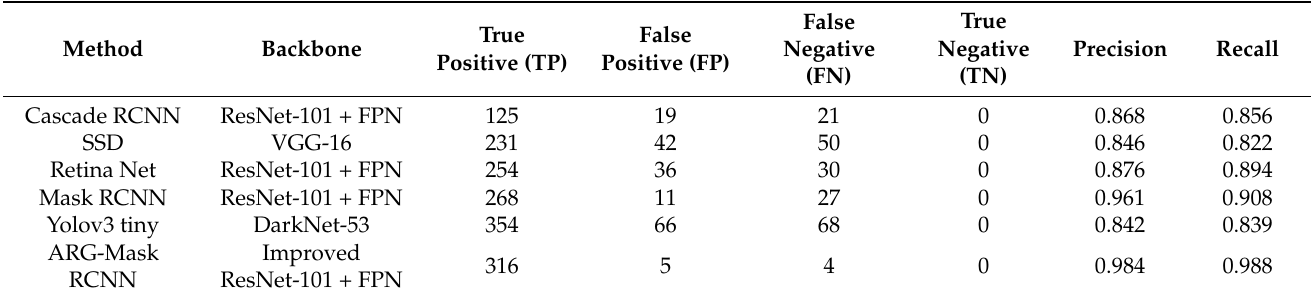
Table 3. Comparison of six different detection methods.